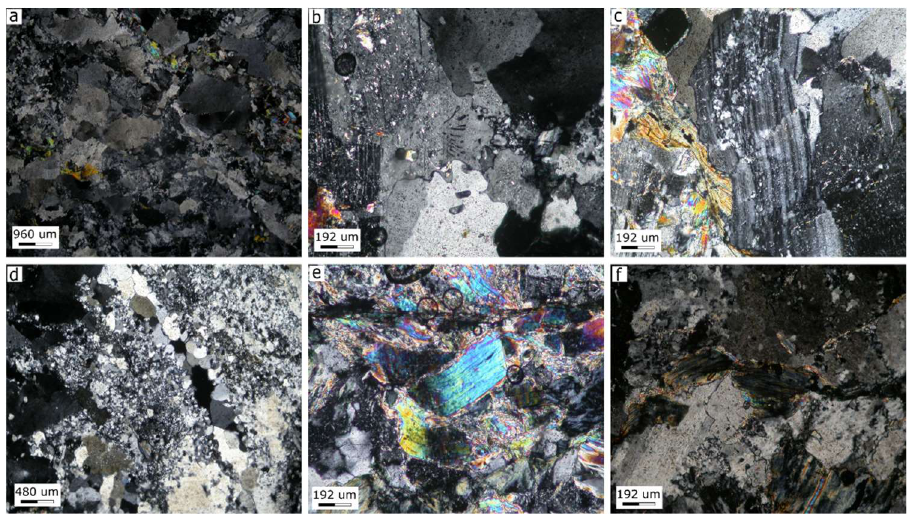
Figure 4. Petrographic major features of the analyzed leucocratic rocks: ( a ) hypidiomorphic granular consertal texture NX, 2 × ; ( b ) vermicular intergrowths between quartz and plagioclase NX, 10 × ; ( c ) deformed plagioclase as indicated by undulose extinction NX, 10 × ; ( d ) quartz with dynamic recrystallization as subgrains and newgrains NX, 4 × ; ( e ) muscovite with undulose extinction NX, 10 × ; ( f ) chlorite pseudomorphs after biotite and with inclusions of apatite, zircon and opaque minerals NX, 10 × . NX = crossed polarizers.